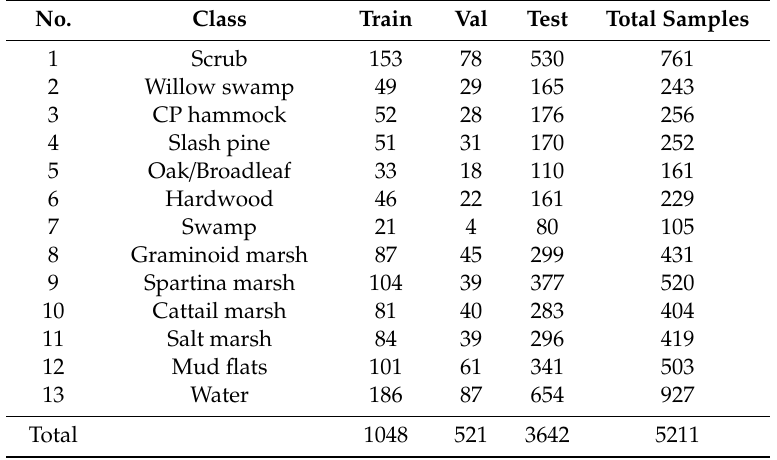
Table 6. The number of training, validation, test, and total samples in the KSC dataset.